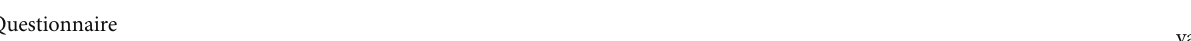
Table 1: Measurement items and Cronbach ’ s α